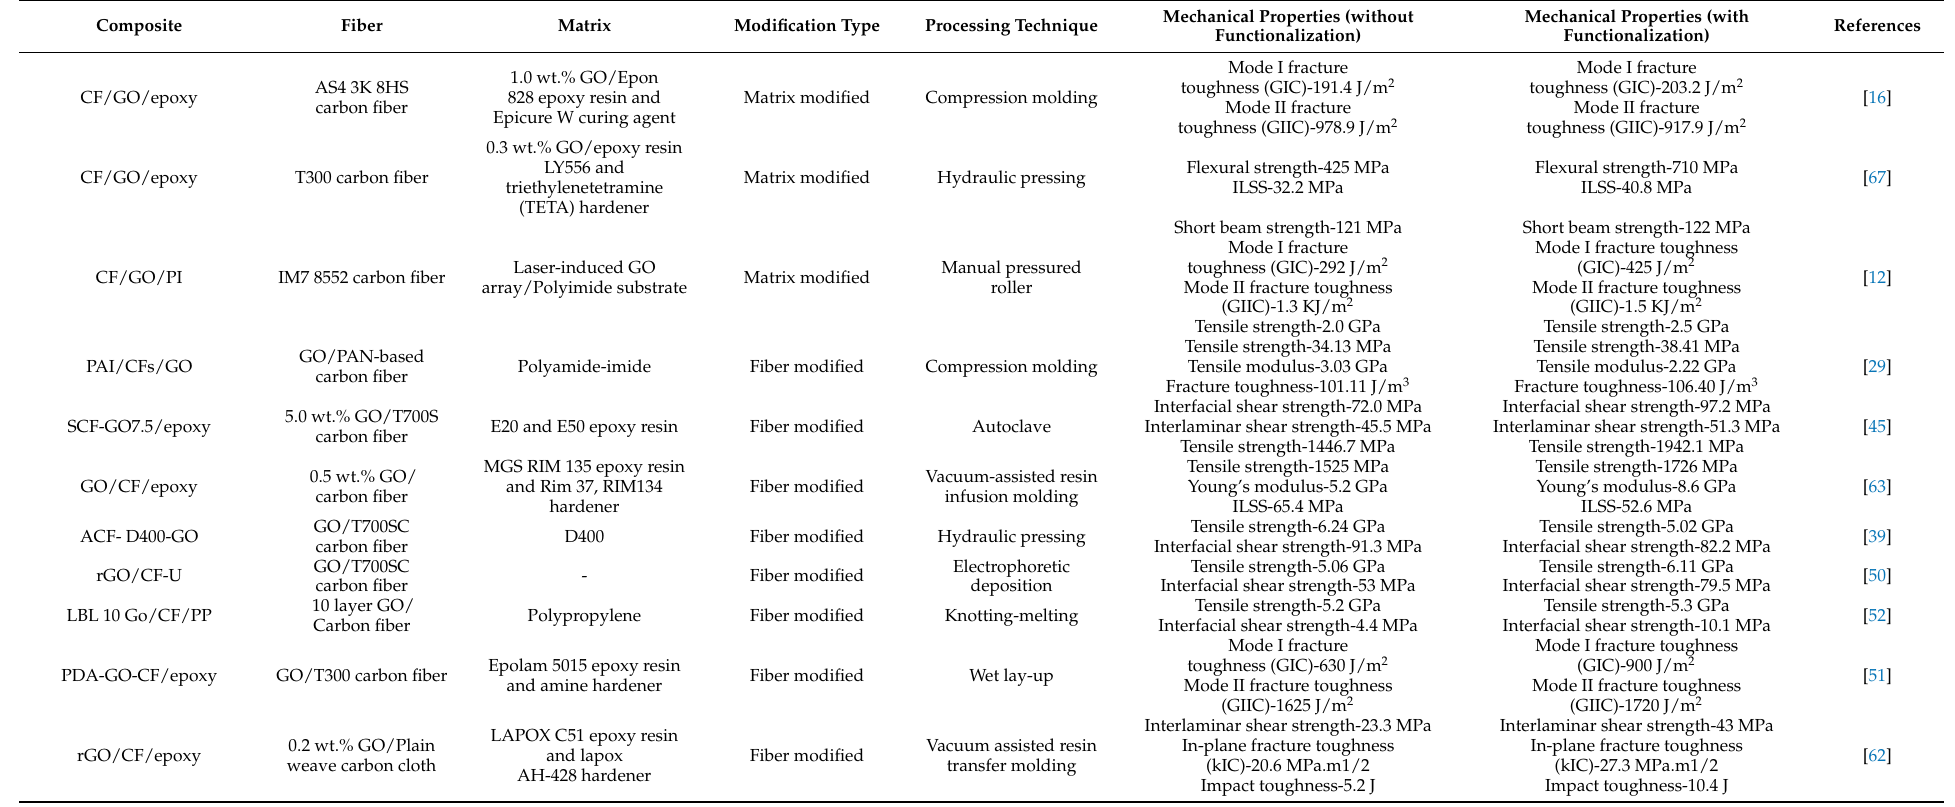
Table 1. Listed mechanical properties of CFRPs with